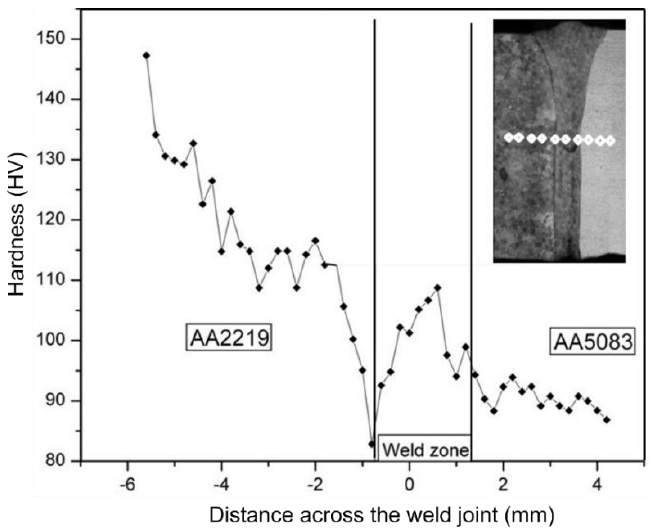
Figure 14. Variation of microhardness across the weld joint at mid-thickness.